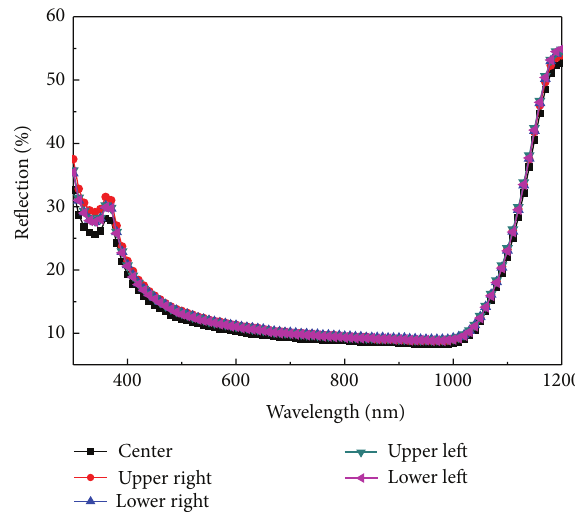
Figure 5: A comparison of the reflection at five different locations within the wafers after the alkaline texturing